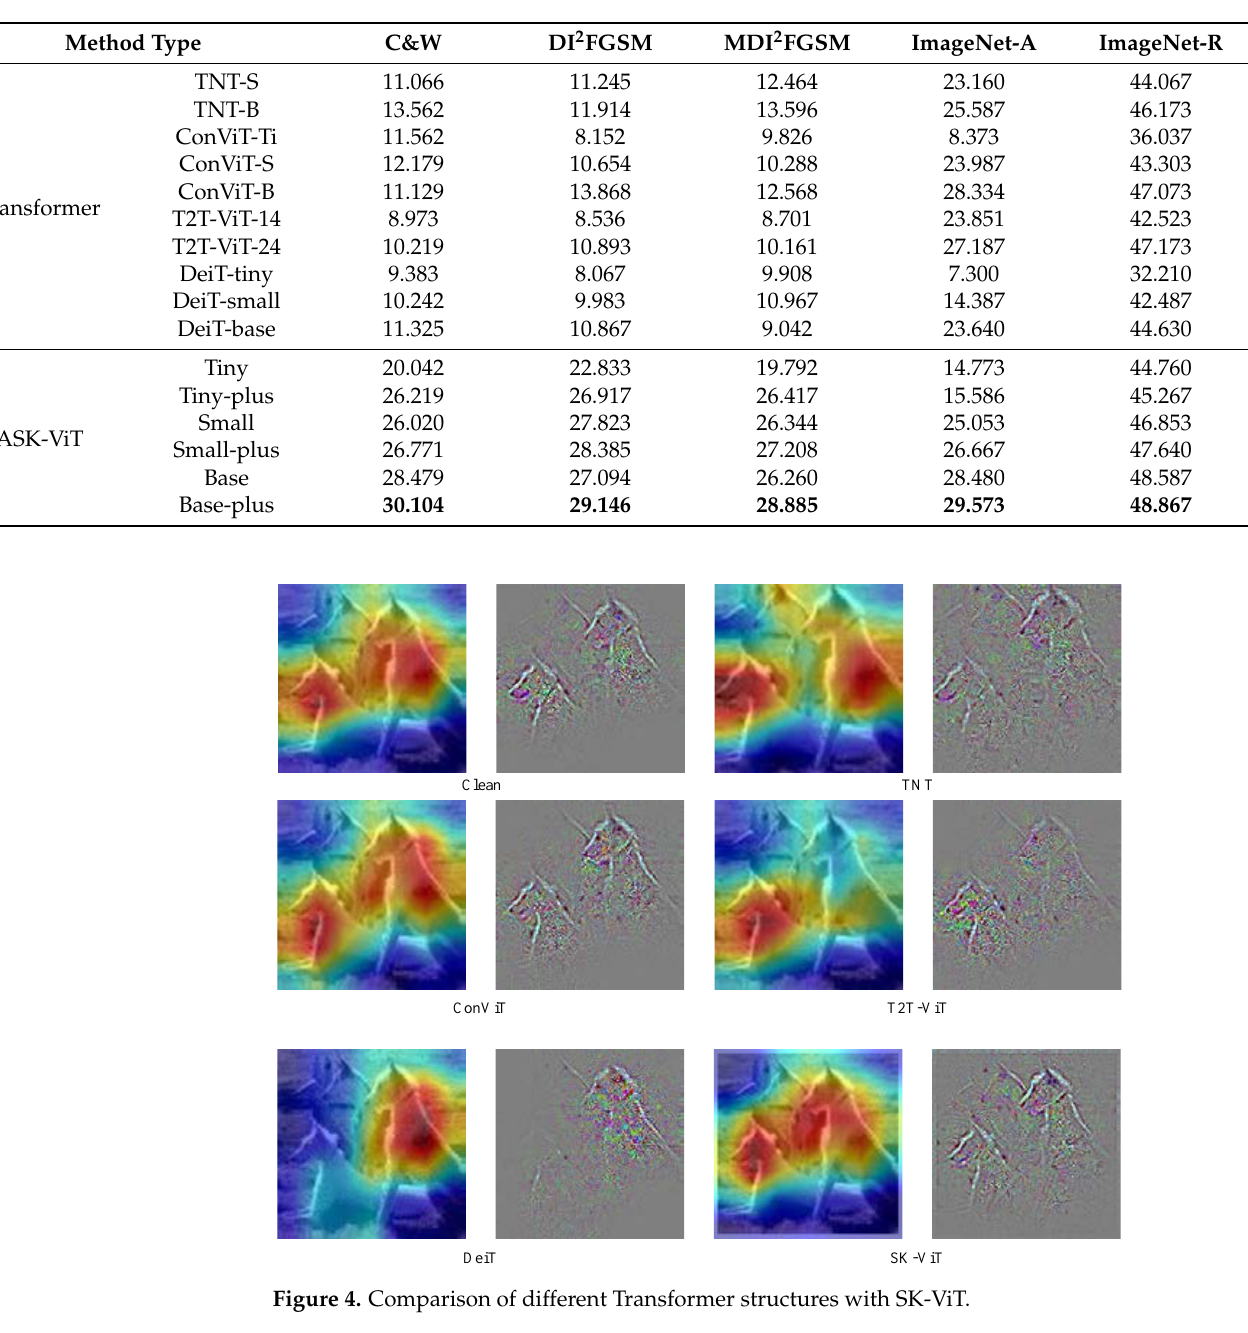
Table 2. Comparison of different network structures.